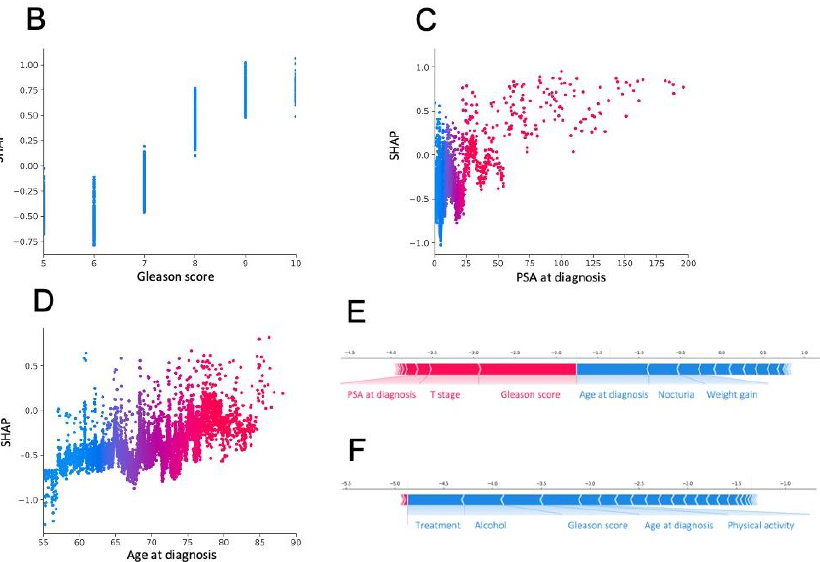
Figure 2. ( A ) The 20 most important features for prostate cancer mortality prediction. Population ( B – D ) and individual ( E , F ) level interpretability. ( B – D ) and individual ( E , F ) level